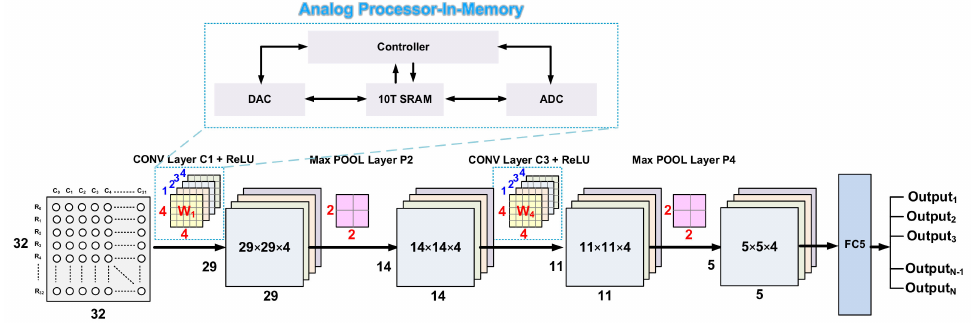
Figure 4. The Proposed CNN Model Architecture.